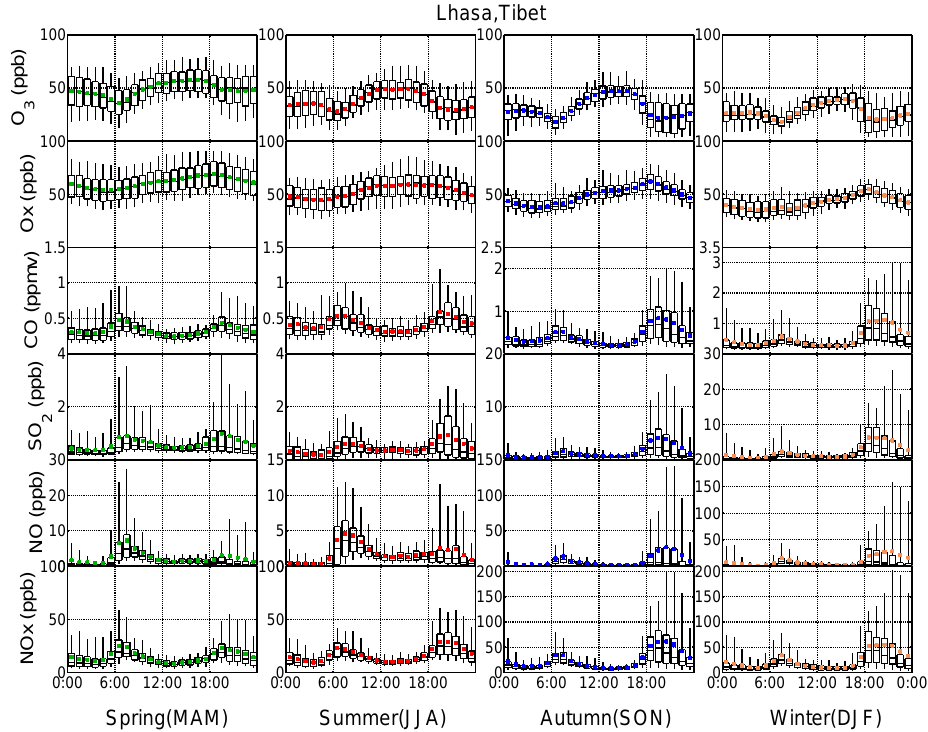
Figure 5. Average diurnal variations of O 3 , O x , CO, SO 2 , NO, and NO x mixing ratios in four seasons (during June 2012 and May 2013) in Lhasa. Colored markers represent hourly mean mixing ratios. Black boxes and whiskers indicate the 5th, 25th, 50th, 75th and 95th percentiles.